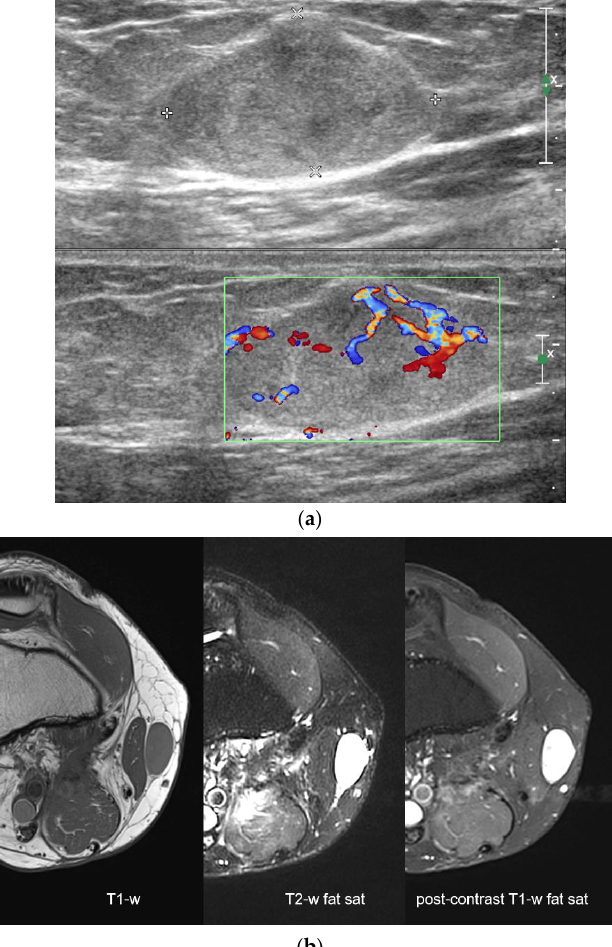
Figure 1. A 38-year-old man operated for a localized liposarcoma of the popliteal fossa. Images obtained after one year show a recurrence. Ultrasound images obtained at the medial aspect of the knee show a hyperechoic nodule ( a ) with intralesional color-Doppler signals and some slightly hypoechoic intralesional areas. MRI images ( b ) show a nodule isointense on T1-weighted sequences and hyperintense on both T2-weighted sequences with fat saturation and post-contrast T1-weighted sequences. Both US and MRI were reported as